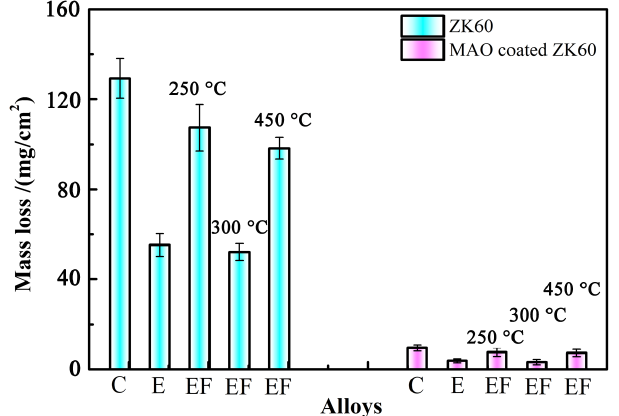
Figure 13. The mass loss results of the uncoated and MAO-coated ZK60 alloy specimens post 35 days of salt spray test.